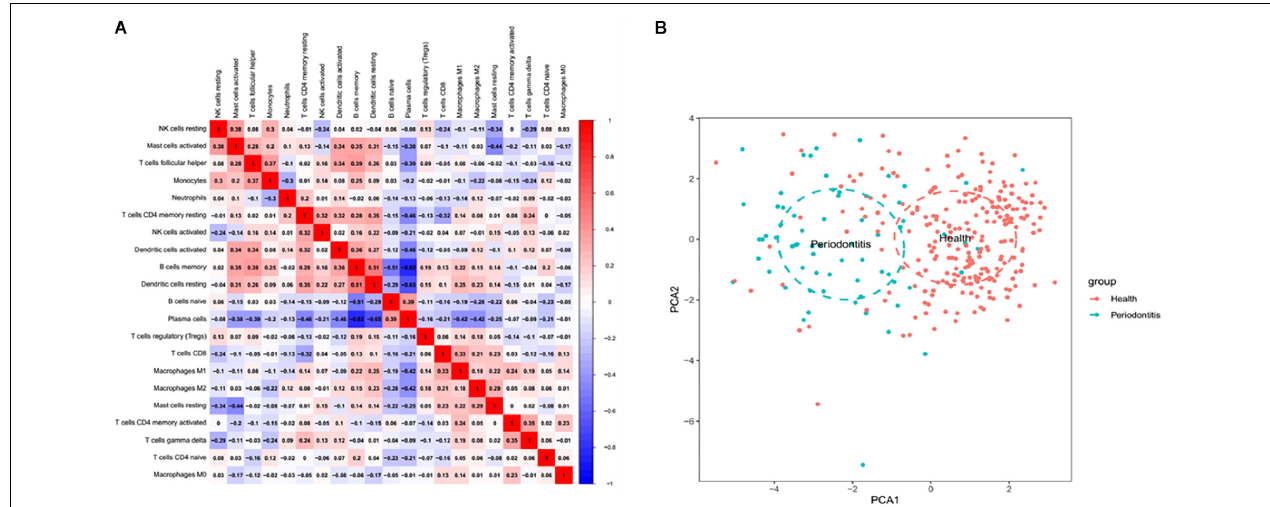
FIGURE 2 | Coherence analysis of immune cell subgroups in gingival tissues with periodontitis. (A) Correlation among immune cell subpopulations. A negative correlation was observed between plasma cells and CD4 memory T cells and between resting DC cells and memory B cells. (B) Principal component analysis between healthy and periodontitis tissues based on infiltrated immune cell